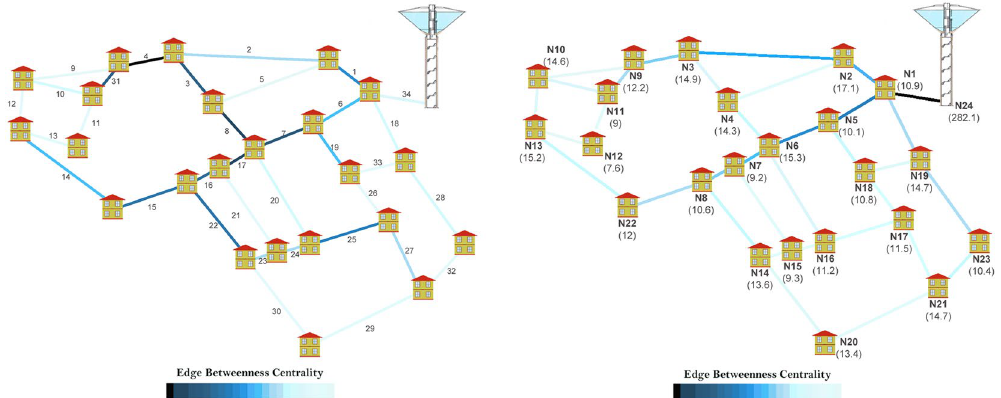
Figure 8. (left) Standard edge betweenness for a water supply network. Source and demand nodes have the same intrinsic relevance equal to 1. The edge betweenness is identified by colored edges ranging from black (maximum value) to cyan (minimum value). The most important pipe is the number 4. (right) Proposed edge betweenness embedding the intrinsic relevance in terms of demand for each node and as sum of demands for the source node (values in l/s are reported close to each node). The pipe 34 results the most important edge.